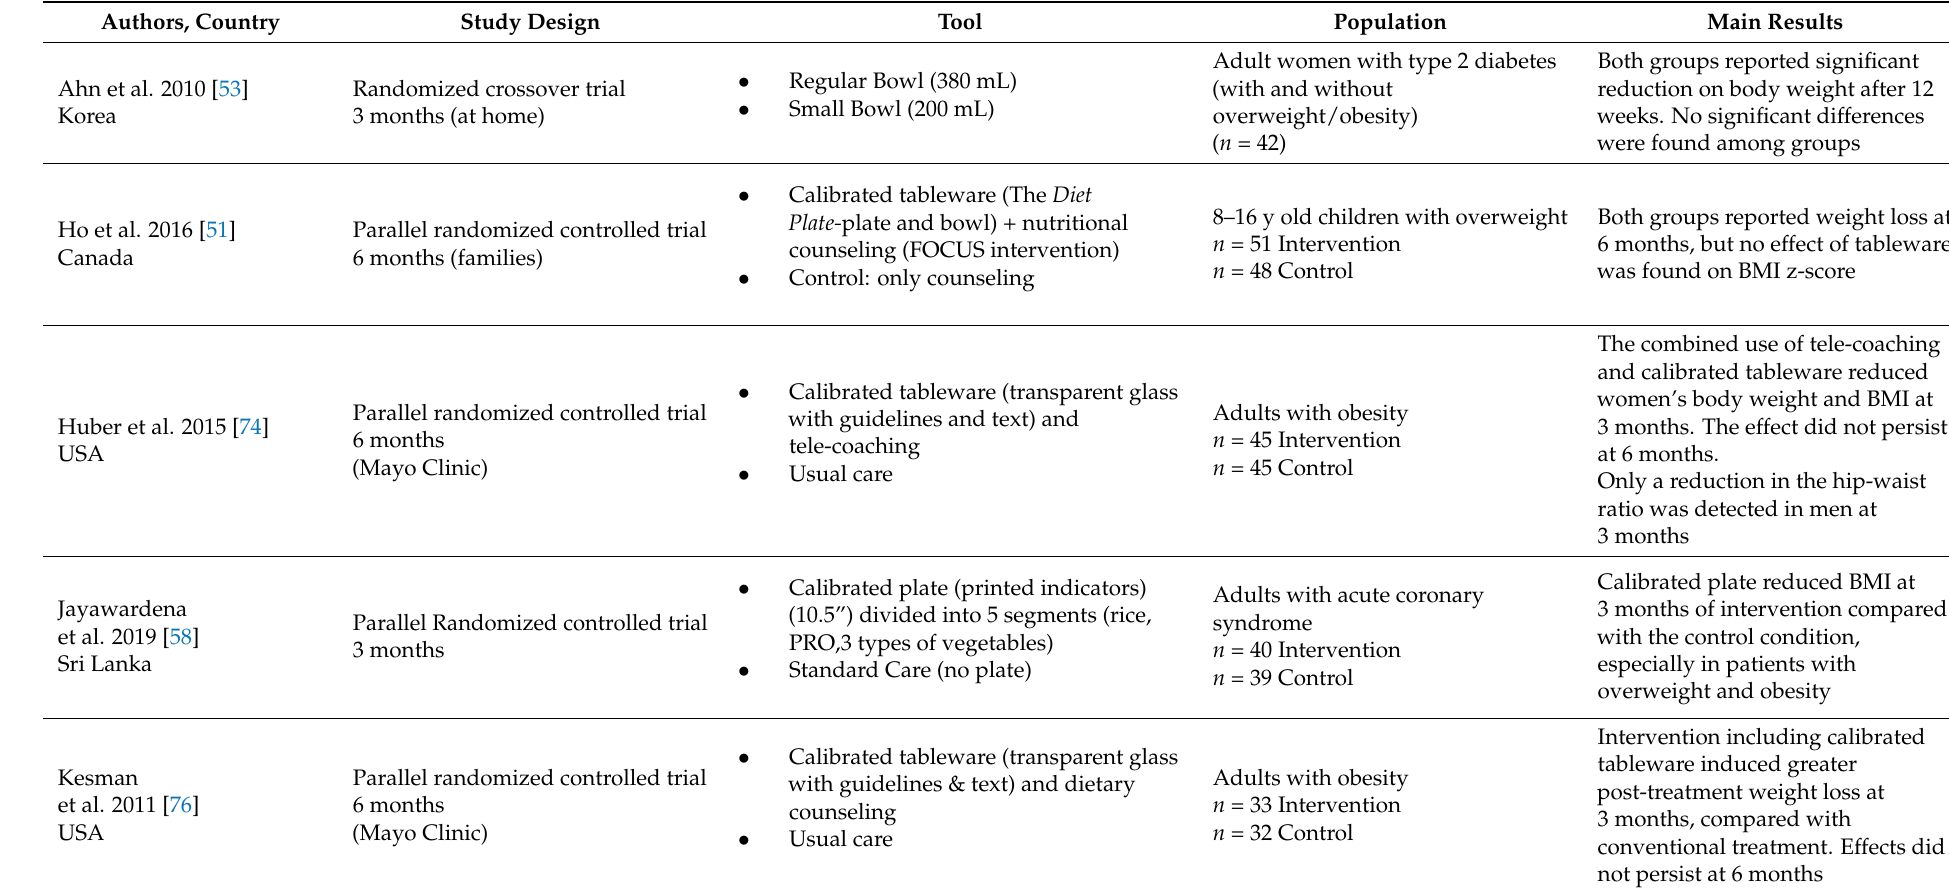
Table 6. Results of studies reporting changes in body weight (change in kg or